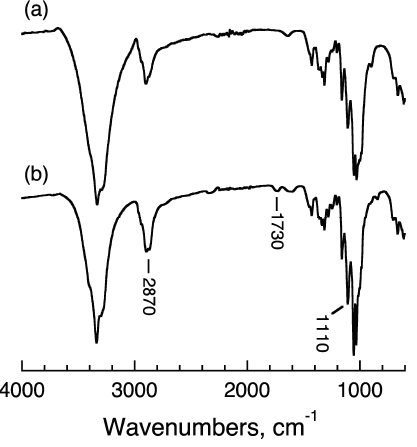
Figure 3. ATR-FTIR spectra of ( a ) ungrafted material and ( b )